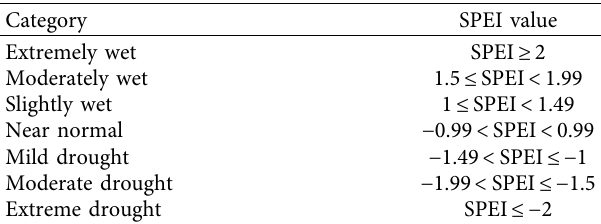
Figure 1: Topographic map of the Qinghai-Tibetan Plateau (adapted from the geospatial data cloud at Beijing (https://www.gscloud.cn/)). Table 1: Drought and wetness classification based on the SPEI value [17, 28,